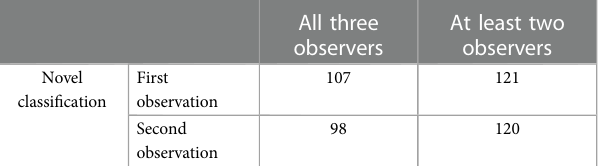
TABLE 6 Agreement among three observers according to the XX classi fi cation.